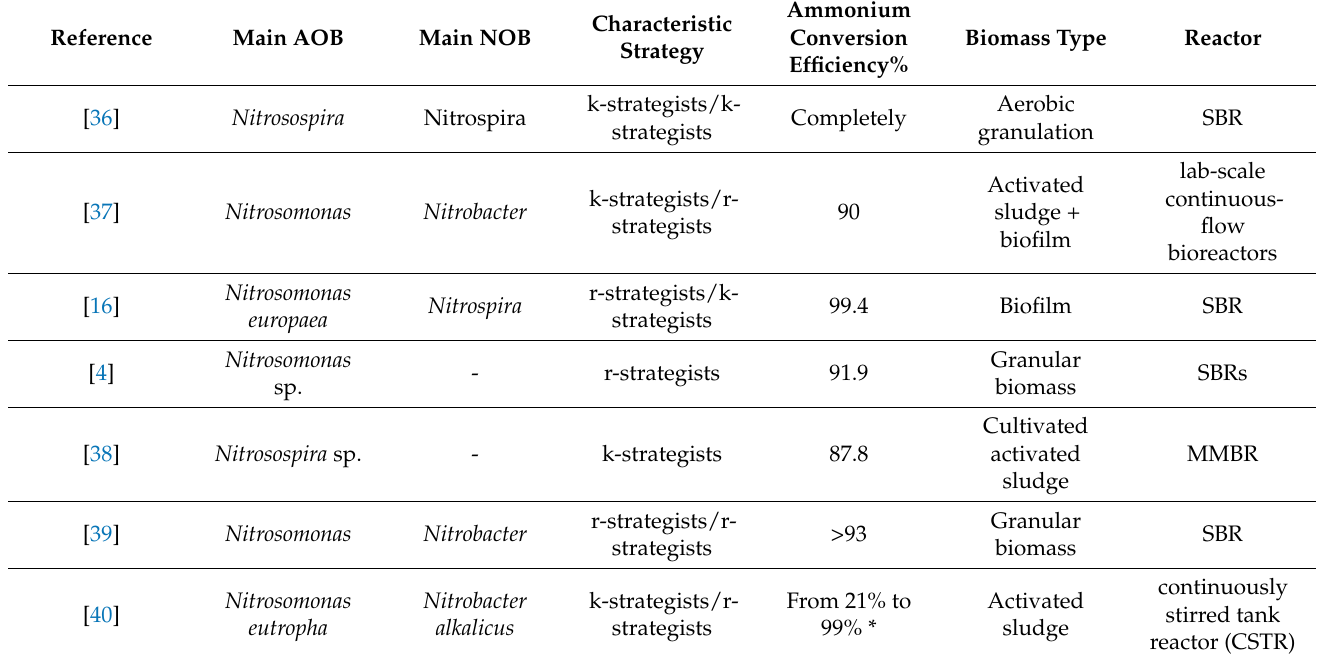
Table 2. Predominating species in different biological